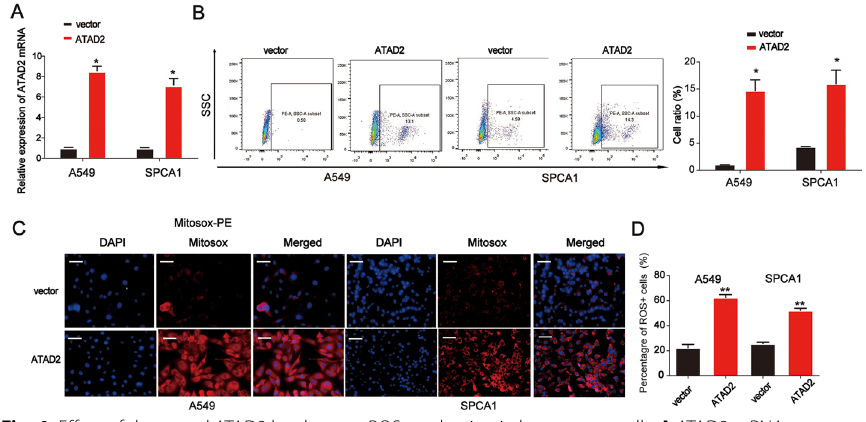
Fig. 4 Effect of decreased ATAD2 levels on mtROS production in lung cancer cells. A ATAD2 mRNA expression in lung cancer cells transfected with the ATAD2 overexpression plasmid. B Cellular mtROS accumulation in A549 and SPC-A1 cells assessed using flow cytometry analysis. C , D Nuclei are stained with Hoechst (blue), and mitochondria ROS are stained using MitoSOX-red in A549 and SPCA1 cells. Merged panels demonstrate the number of MitoSOX-red positive cells among the total cells. Scale bar bars indicate mean SD. All experiments performed in triplicate. * p < ±